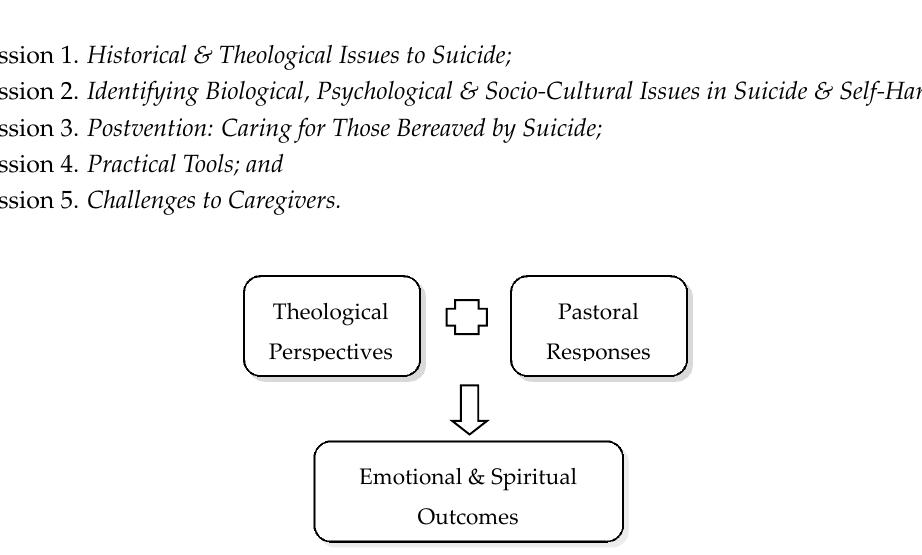
Figure 1. The influence of theological perspectives in pastoral responses on outcomes.